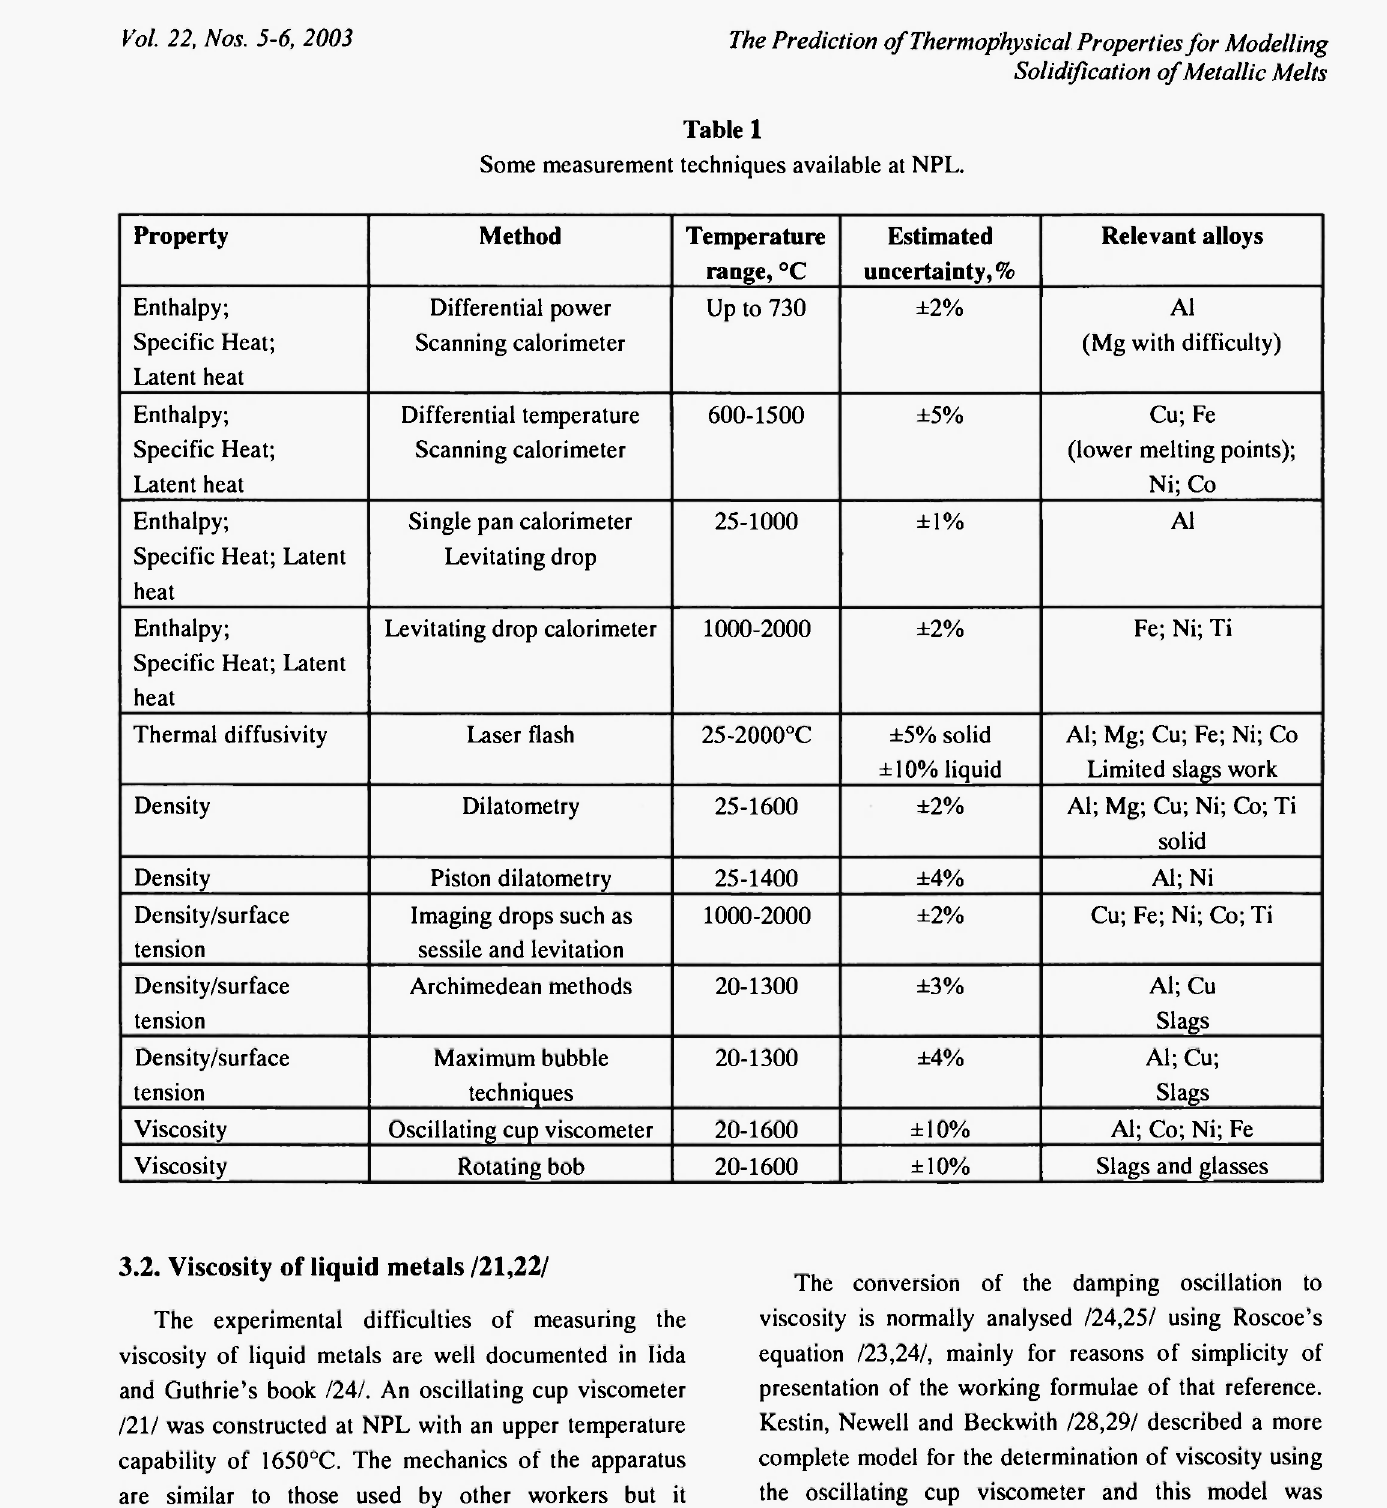
Some measurement techniques available at